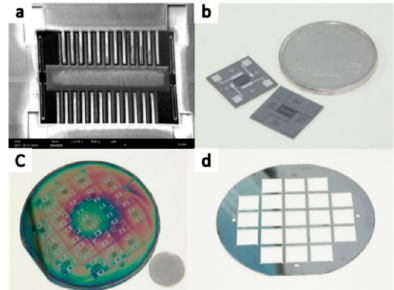
Figure 14. Picture of the asymmetric structure accelerometer: ( a ) the result of the SEM observation, ( b ) the small pattern taken by the camera, ( c ) the wafer that was not etched, ( d ) the frame that was etched away.